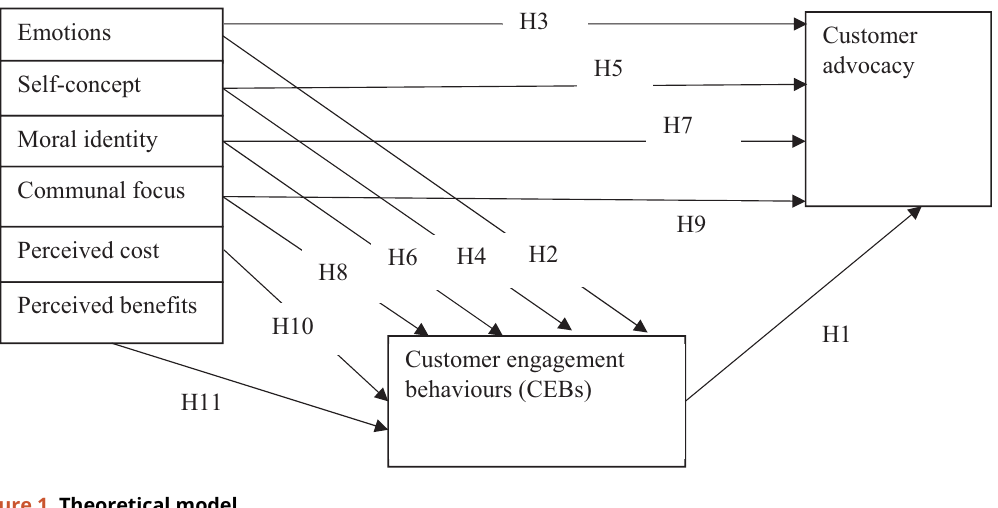
Figure 1. Theoretical